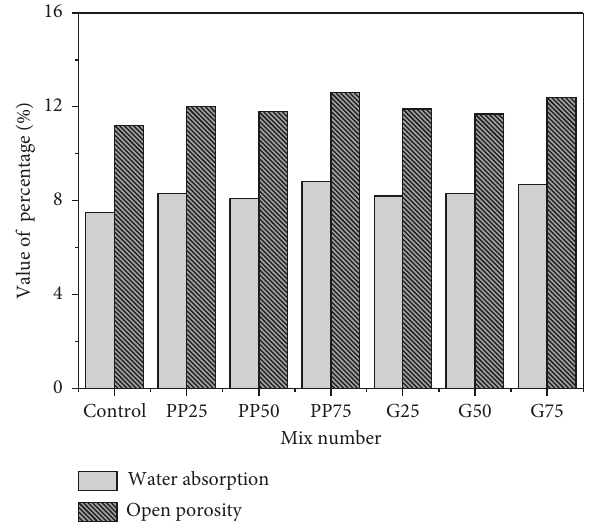
Figure 11: Relationship between the compressive strength and MOE.